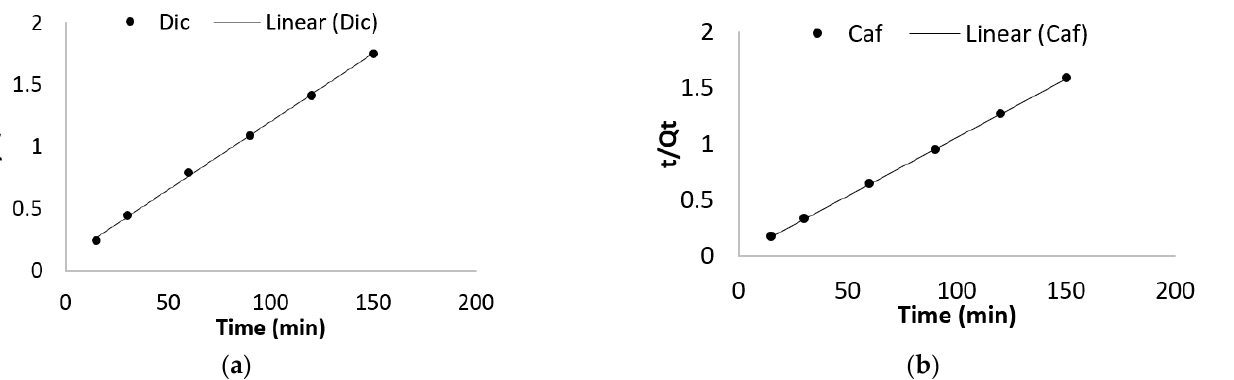
Figure 8. Pseudo-second-order kinetic model applied to the adsorption of Caf ( a ) and Dic ( b ) on activated carbon from argan nutshells.